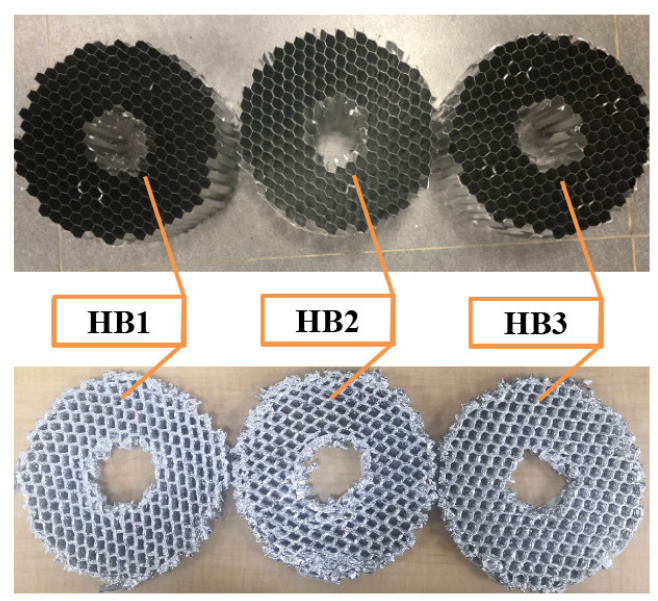
Figure 6. Static pressure experiment results. Table 2. Experiment compression ratio.